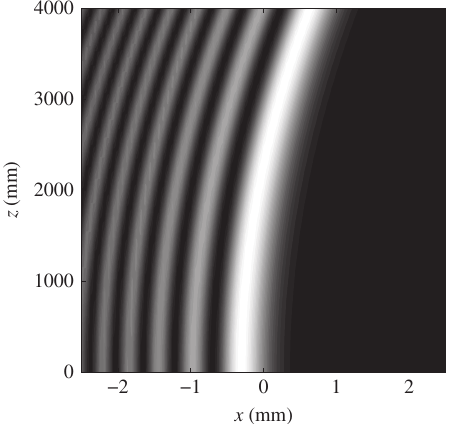
Figure 14: The propagation of an Airy beam with λ = 0.5 μ m and = 0.3 mm. x 0